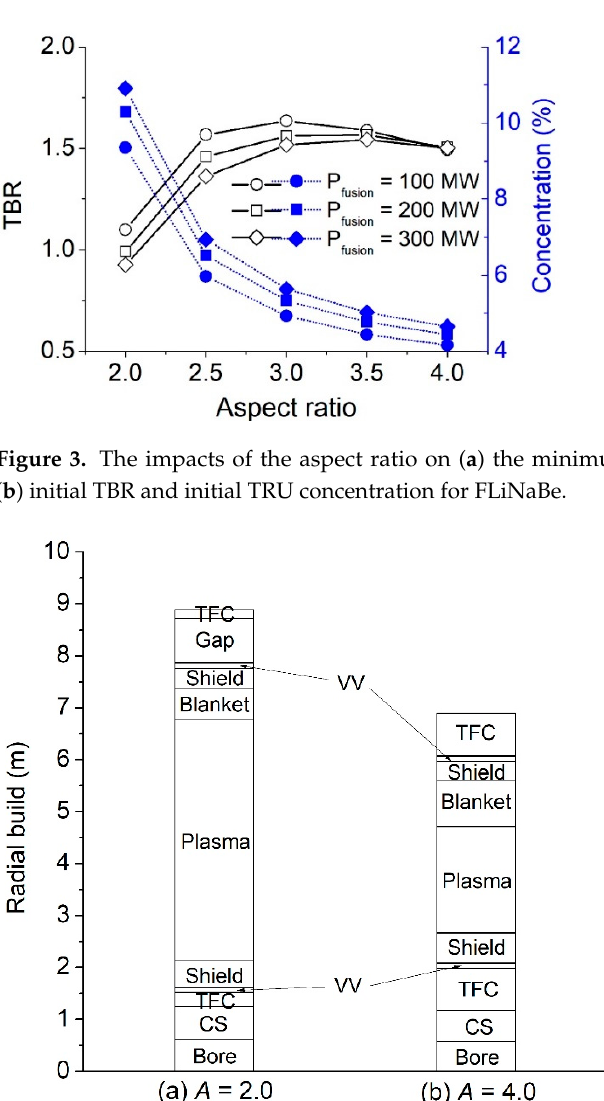
Figure 3. The impacts of the aspect ratio on ( a ) the minimum R 0 and the neutron wall loading; ( b ) initial TBR and initial TRU concentration for FLiNaBe.